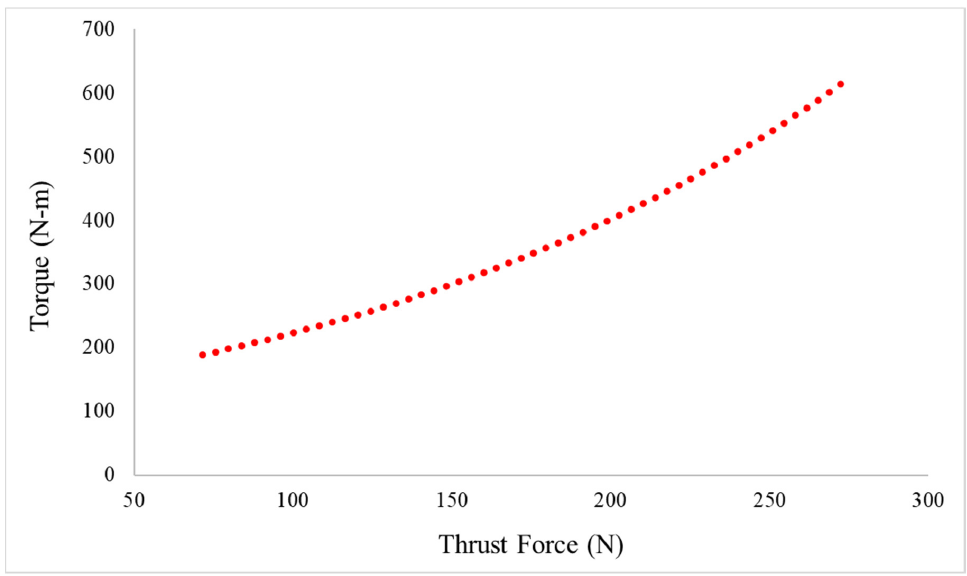
Figure 18. Pareto optimal fronts.